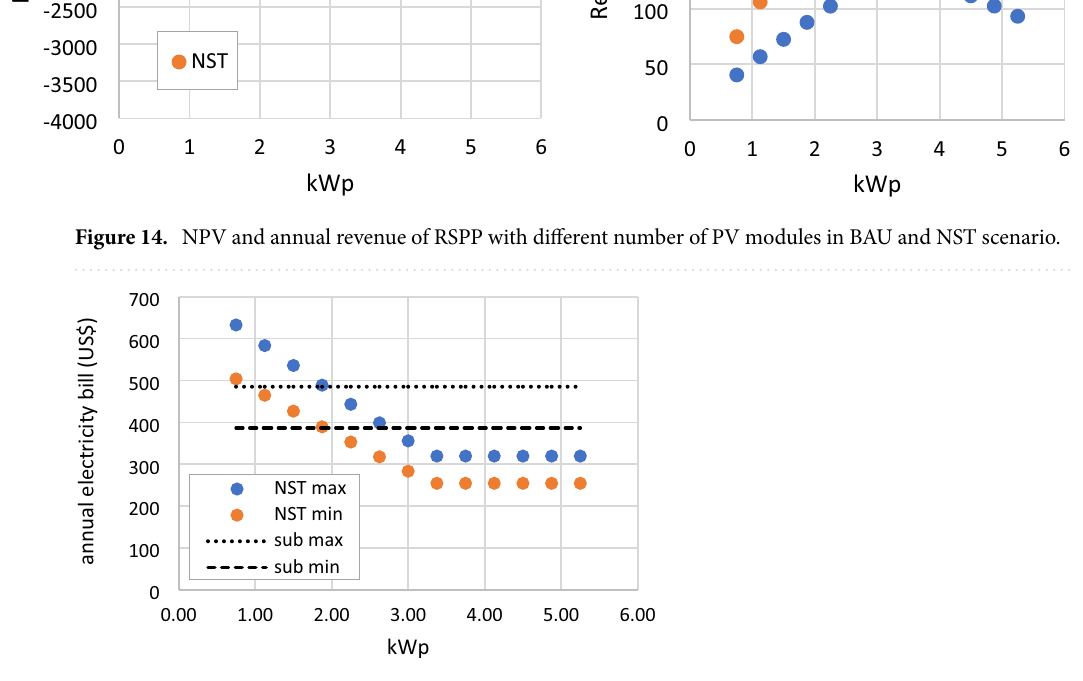
Figure 15. annual electricity bill for NST scenario and subsidized tariff scheme with no